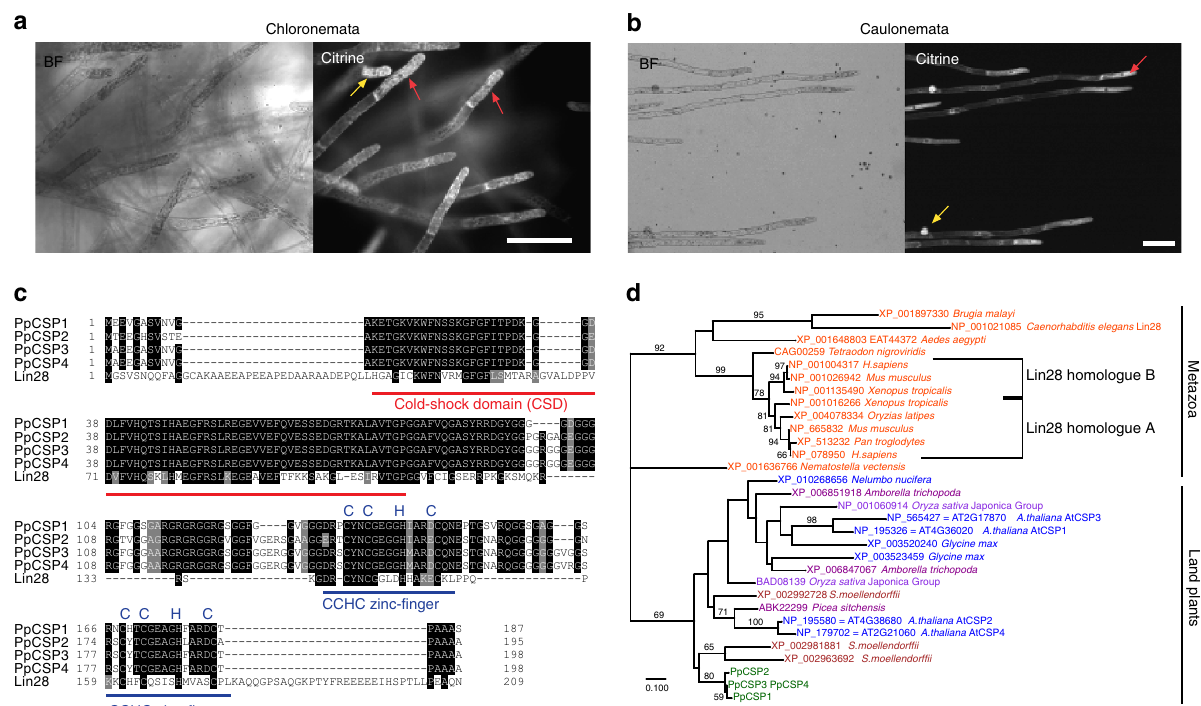
Figure 1 | PpCSP1 that shares conserved domains with Lin28 is expressed in protonema apical stem cells. ( a , b ) Bright-field (BF) and fluorescence (Citrine) images of chloronemata ( a ) and caulonemata ( b ) of the nPpCSP1-Citrine-nosT #136 line. Red and yellow arrows indicate apical stem cells and side branch initial cells, respectively. ( c ) Alignment of the amino acid sequences of PpCSPs and human Lin28 proteins. PpCSPs and human Lin28 proteins were predicted to contain one CSD (red line) and two CCHC zinc-finger domains (blue lines). Black and grey shades indicate identical amino acids and amino acids with similar characters to the consensus amino acid, respectively. ( d ) Phylogeny of PpCSP1, Lin28 and related proteins, with a cold-shock domain and zinc-finger domains. The maximum likelihood tree was constructed using amino acid sequences of the proteins. The wag model of amino acid substitution was used. Branch lengths are proportional to the number of substituted residues. Bootstrap probability 4 50% is indicated on the branches (estimated by 1,000 resampling). The accession numbers and species names are indicated. Colour of the OTU represents the phylogenetic position: Orange, metazoans; blue, eudicots; light purple, monocots; dark purple, other seed plants including gymnosperms and basal angiosperms; green, bryophytes; brown, lycophytes. This is an unrooted tree. The left-most node was chosen for the best match of organism phylogeny. Mammalian Lin28 genes used for the iPSC reprogramming are included in the ‘Lin28 homologue A’. Scale bars, 100 m m ( a , b ). The scale bar represents the number of amino acid substitutions per site in d